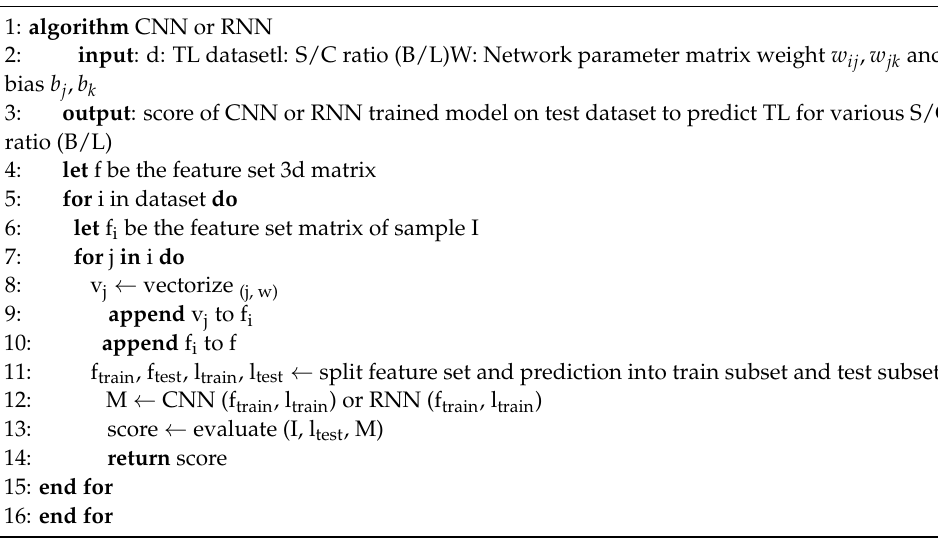
Algorithm 1 . Training and evaluating of CNN and or RNN.